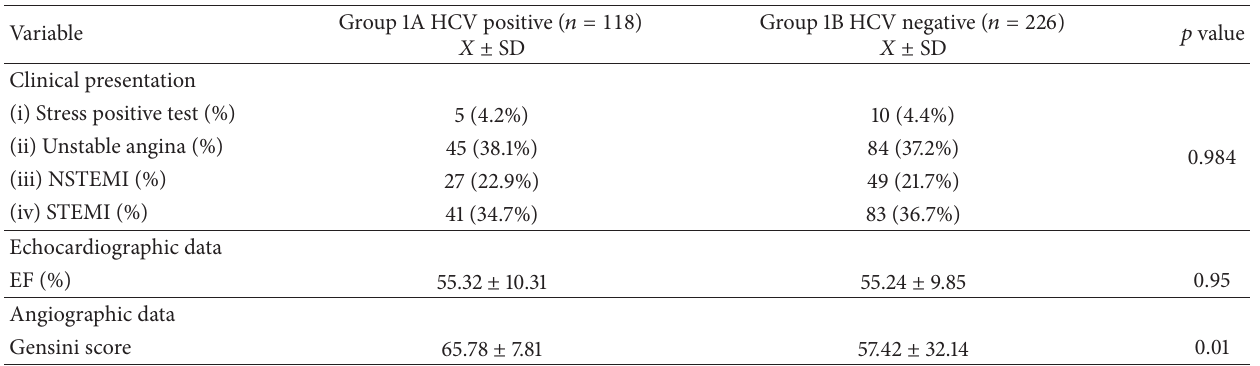
Table 3: Clinical presentation and echocardiographic and angiographic characteristics of HCV positive and HCV negative groups. Variable Clinical